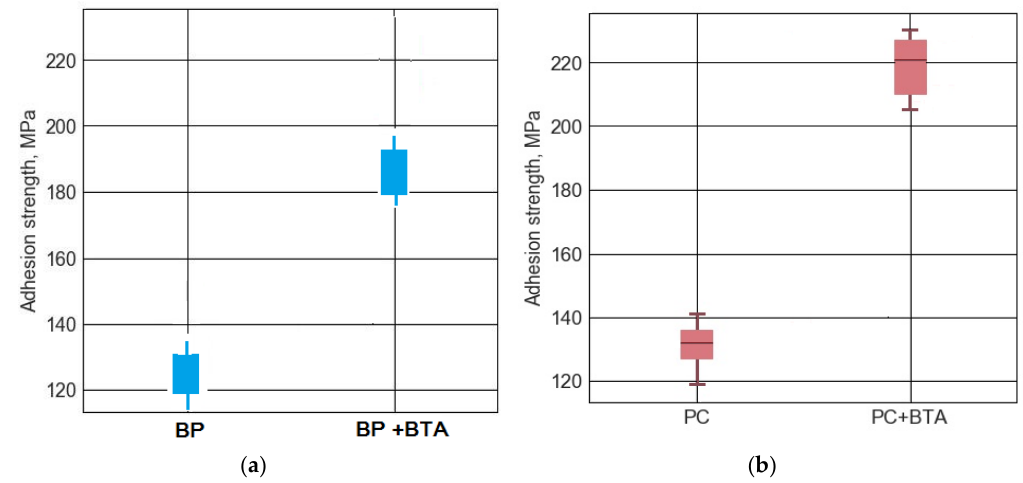
Figure 8. Strength of the adhesion for metal (steel)-polymer coatings (BP and PCA) for nonmodified and modified (BP+BTA) and (PC+ BTA) steel surfaces: ( a ) bitumen-polymeric coating (BP); ( b ) pentaphtalic paint coating (PC). Error bars correspond to measurements of three specimens.